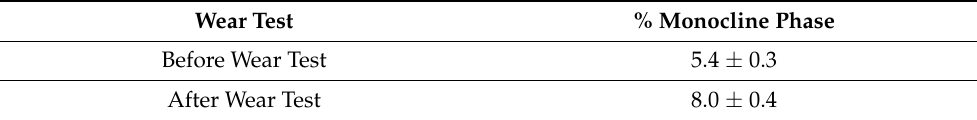
Table 4. Mean monoclinic zirconia content ( ± instrumental error) in ZTA femoral